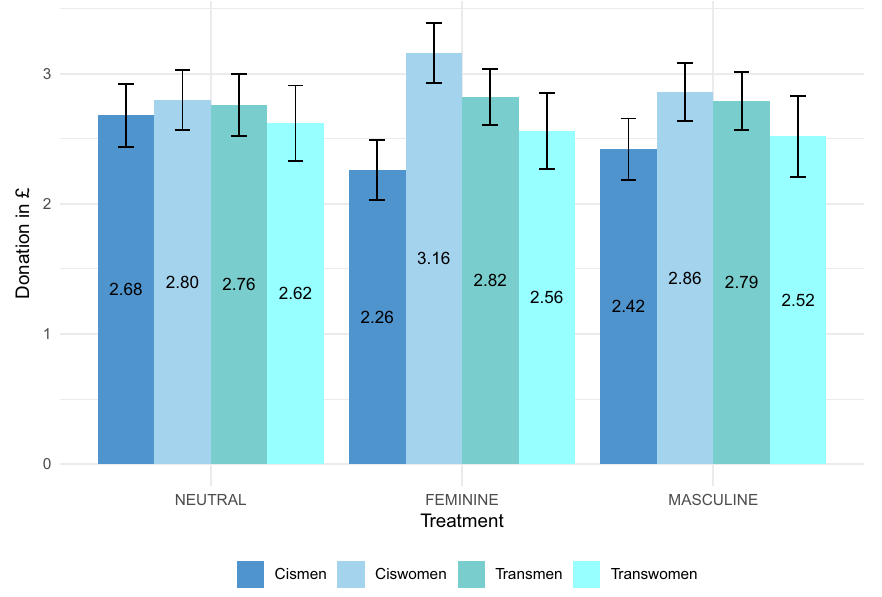
Figure 3. Donation in Part 6 by treatment and subject groups in alphabetical order ( n = 780 ). The average donations are indicated by the bars, and the error bars represent the standard errors of the